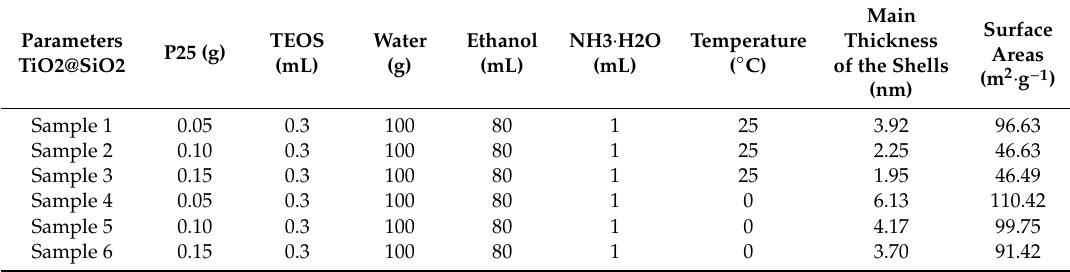
Table 2. Experimental parameters of TiO 2 @SiO 2